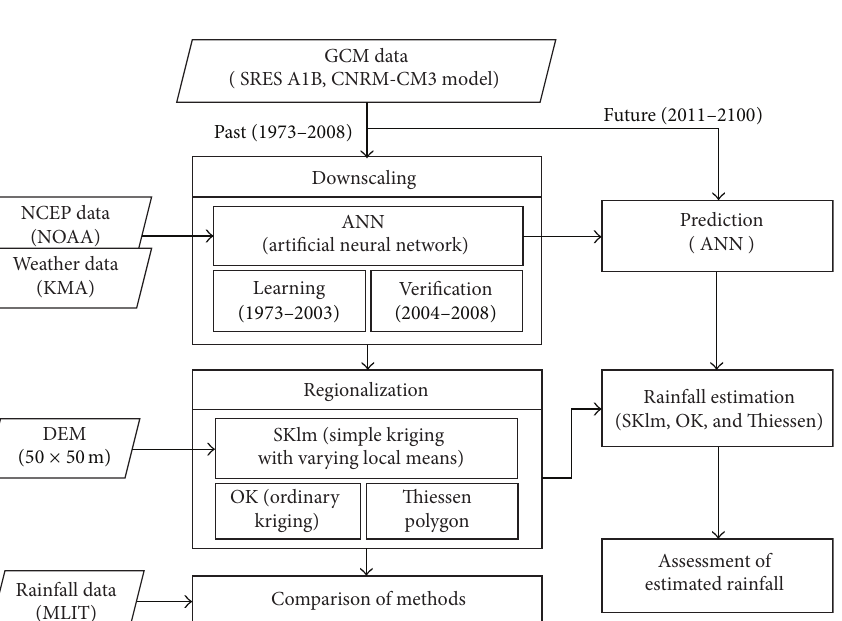
Figure 3: Flowchart of the study.